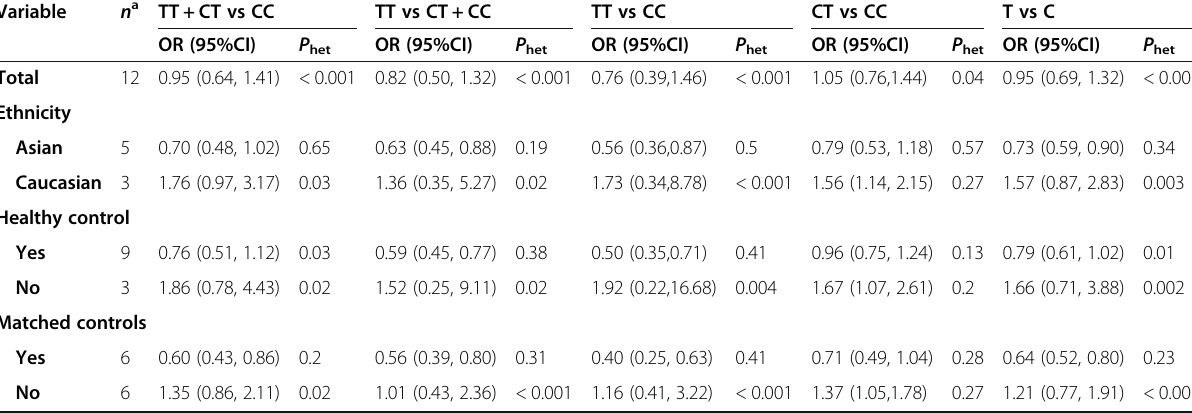
Table 3 Stratified analysis of the association between GABRG2 rs211037 polymorphism and FS